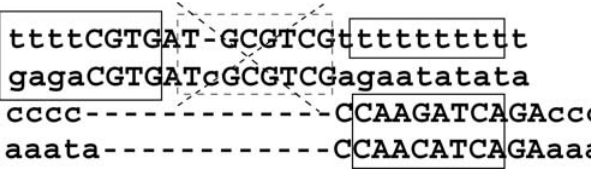
Vertically aligned capital letters are phylogenetically related bases, assumed to have evolved from a common ancestor. Thus, any window placed on these bases is extended to cover all related bases. Three legitimate windows are surrounded by solid boxes. The window surrounded by the dotted box is illegitimate because the gap in the top sequence makes the alignment of bases inconsistent. Note that lower case letters are not aligned and that, in order to complete a window with aligned sequences, one may slide lowercase bases ‘‘ through ’’ adjoining gaps. For example, if the window on the bottom two sequences were to move two steps to the left, the ‘‘ c ’’ and ‘‘ a ’’ on the left side of the preceding gaps would slide through the gaps to the right to complete the